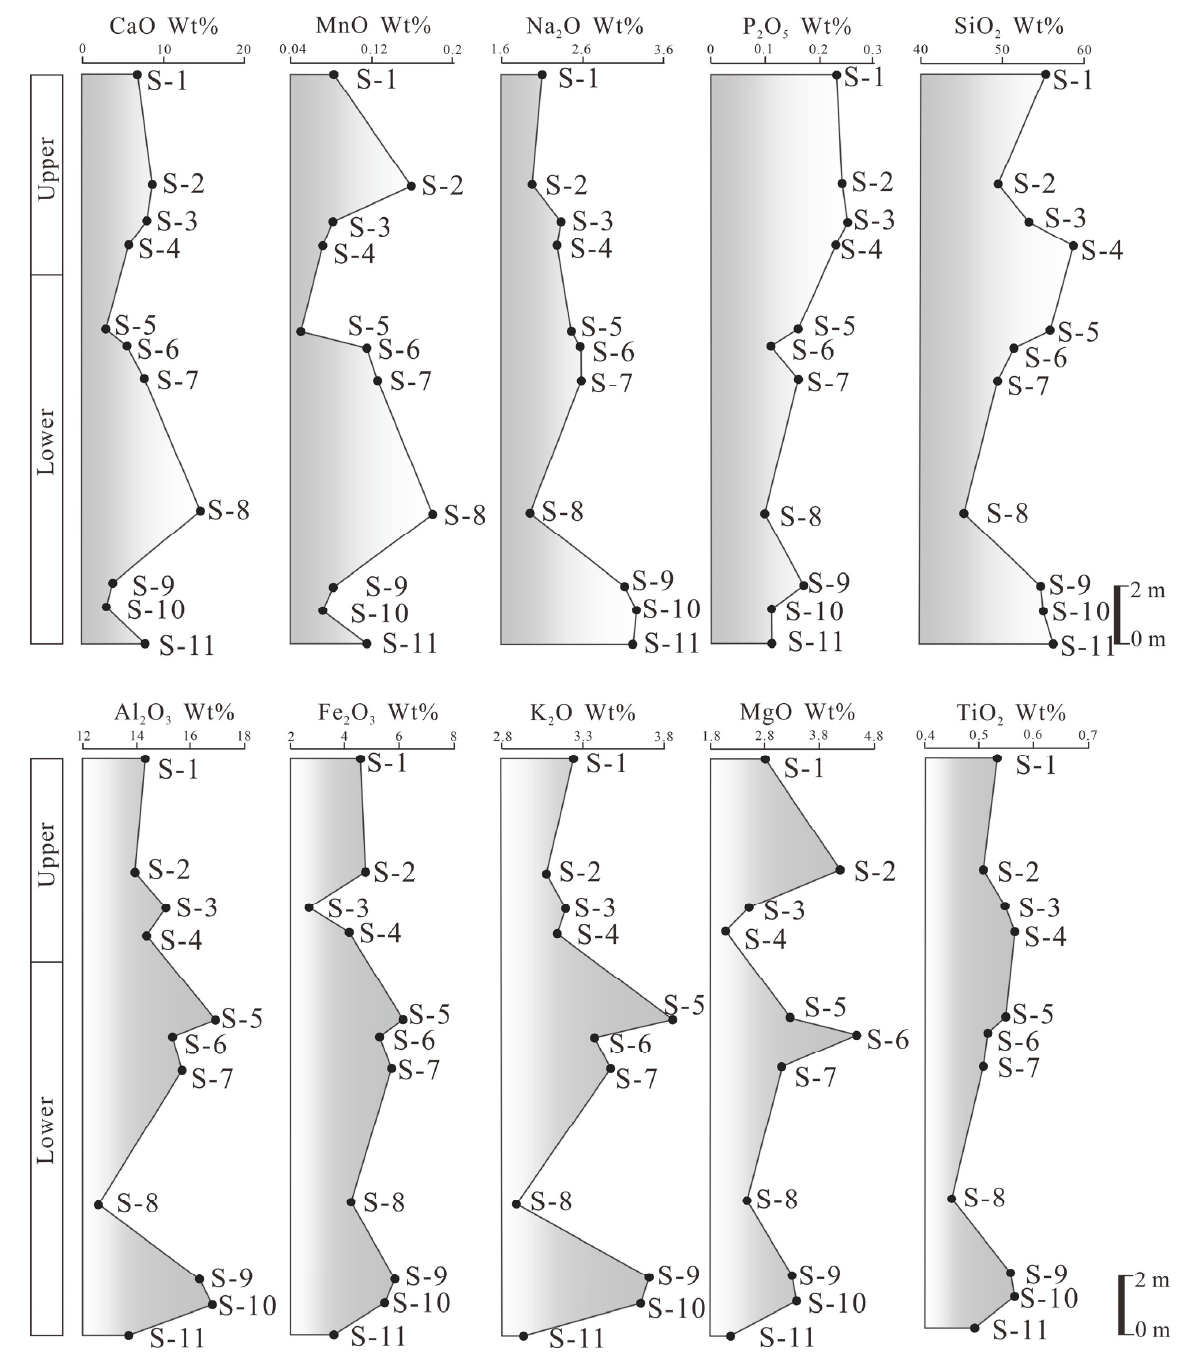
Figure 6. Vertical variations of major elements in the measured section of the Yaojia Formation. See Figure 2A for the location of the samples.